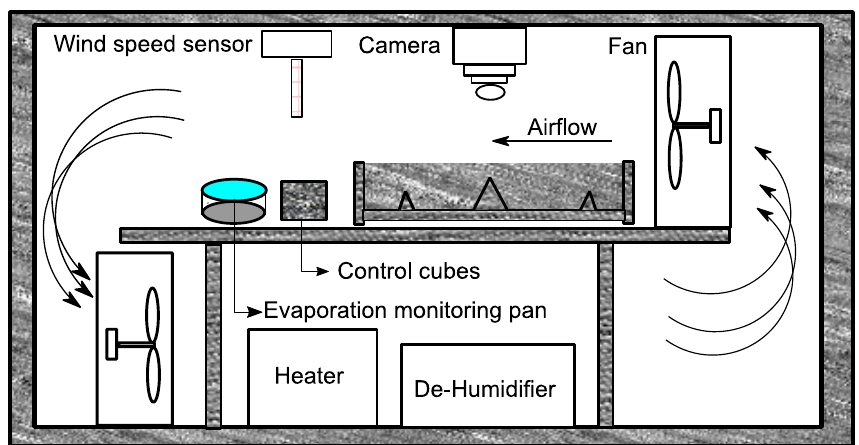
Figure 5. Schematic section of the chamber.